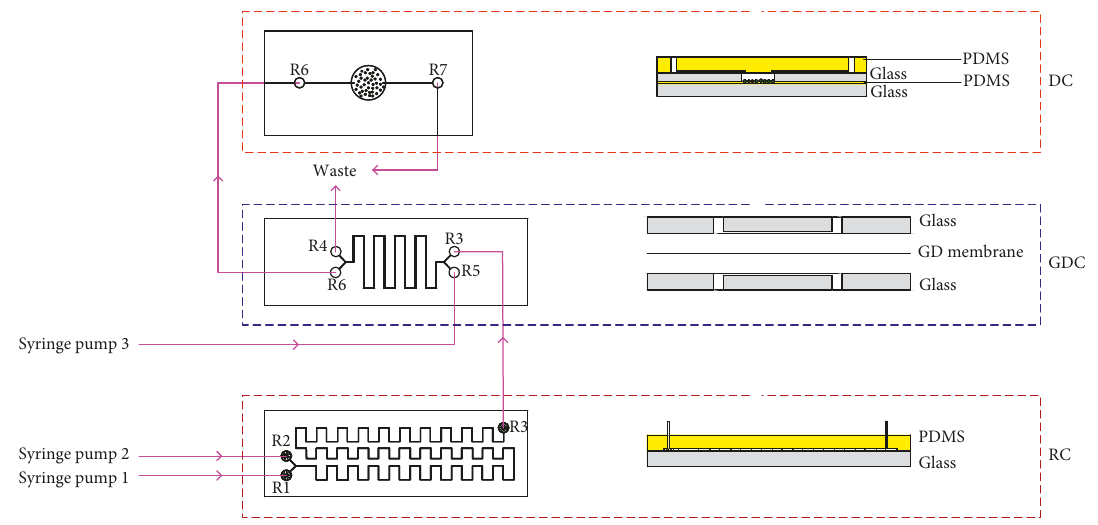
Figure 4: Schematic of the CC and the detailed structure of the RC, GDC, and DC.